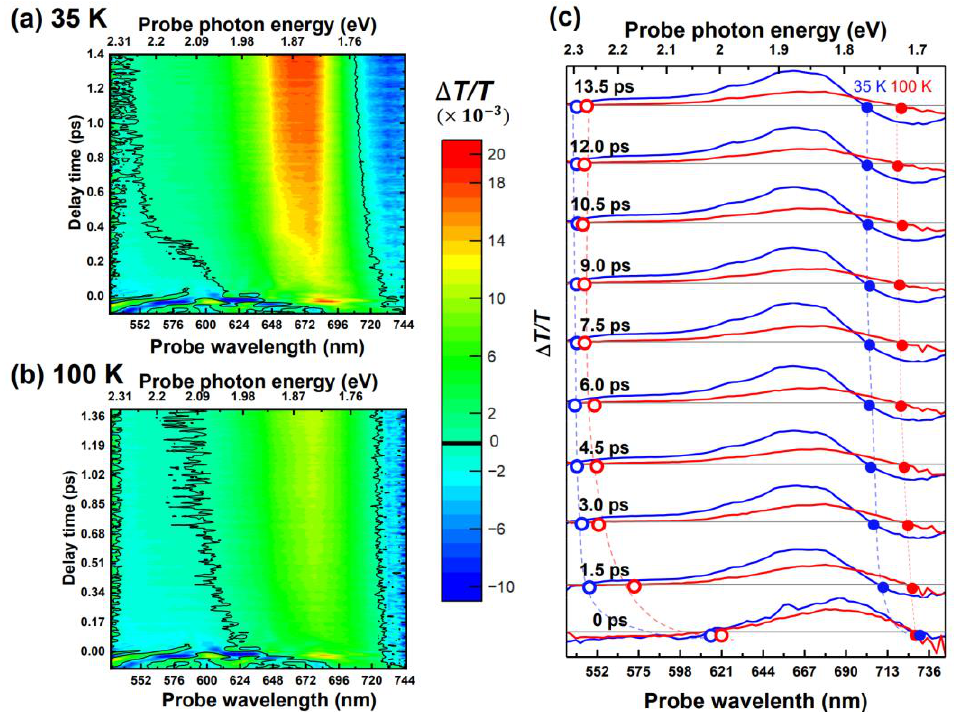
Figure 2. ( a , b ) Two-dimensional plots of the transient difference transmittance ∆ T / T at temperatures below (35 K) and above (100 K) T N . ( c ) Time-resolved ∆ T / T spectra at different delay time between the pump and probe pulses at 35 K (blue) and 100 K (red). The horizontal gray lines show where ∆ T / T = 0. The solid and hollow dots represent the boundary of d - d transitions, and the solid and hollow dots respectively indicate the time-resolved E dd2 ( e 2g → a 1g ) and E dd1 ( e 1g → a 1g ) transitions. The dashed lines are guides for eyes to represent the time evolution of these transitions.